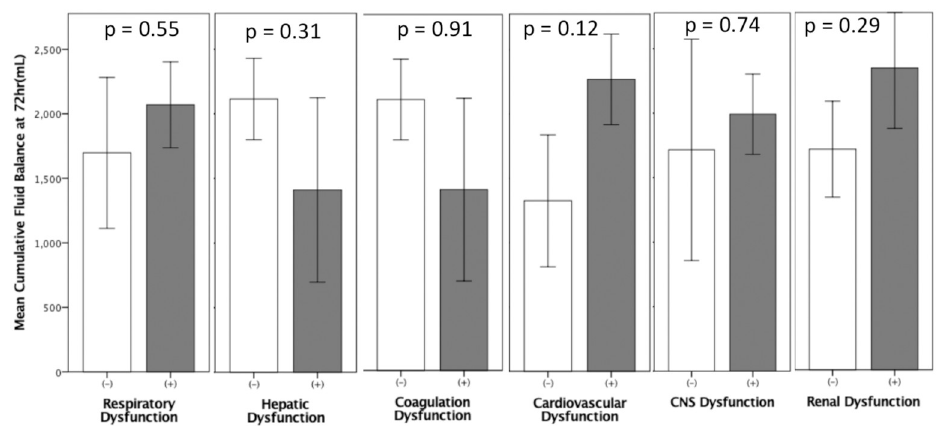
Fig 5. Comparison of 72-hr cumulative fluid balance (CFB) between patients with and without individual organ dysfunction. No significant difference in 72-hr CFB was observed between patients with and without individual organ failure (p values analyzed using Student t test; data expressed as mean ± SEM).